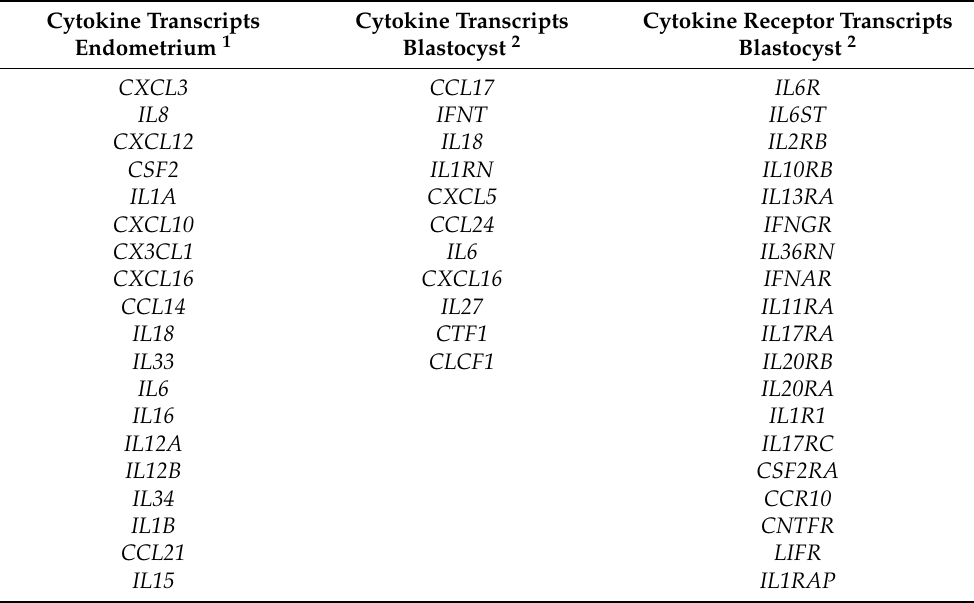
Table 1. Cytokines expressed by the bovine endometrium and cytokines and cytokine receptors expressed by IVP bovine